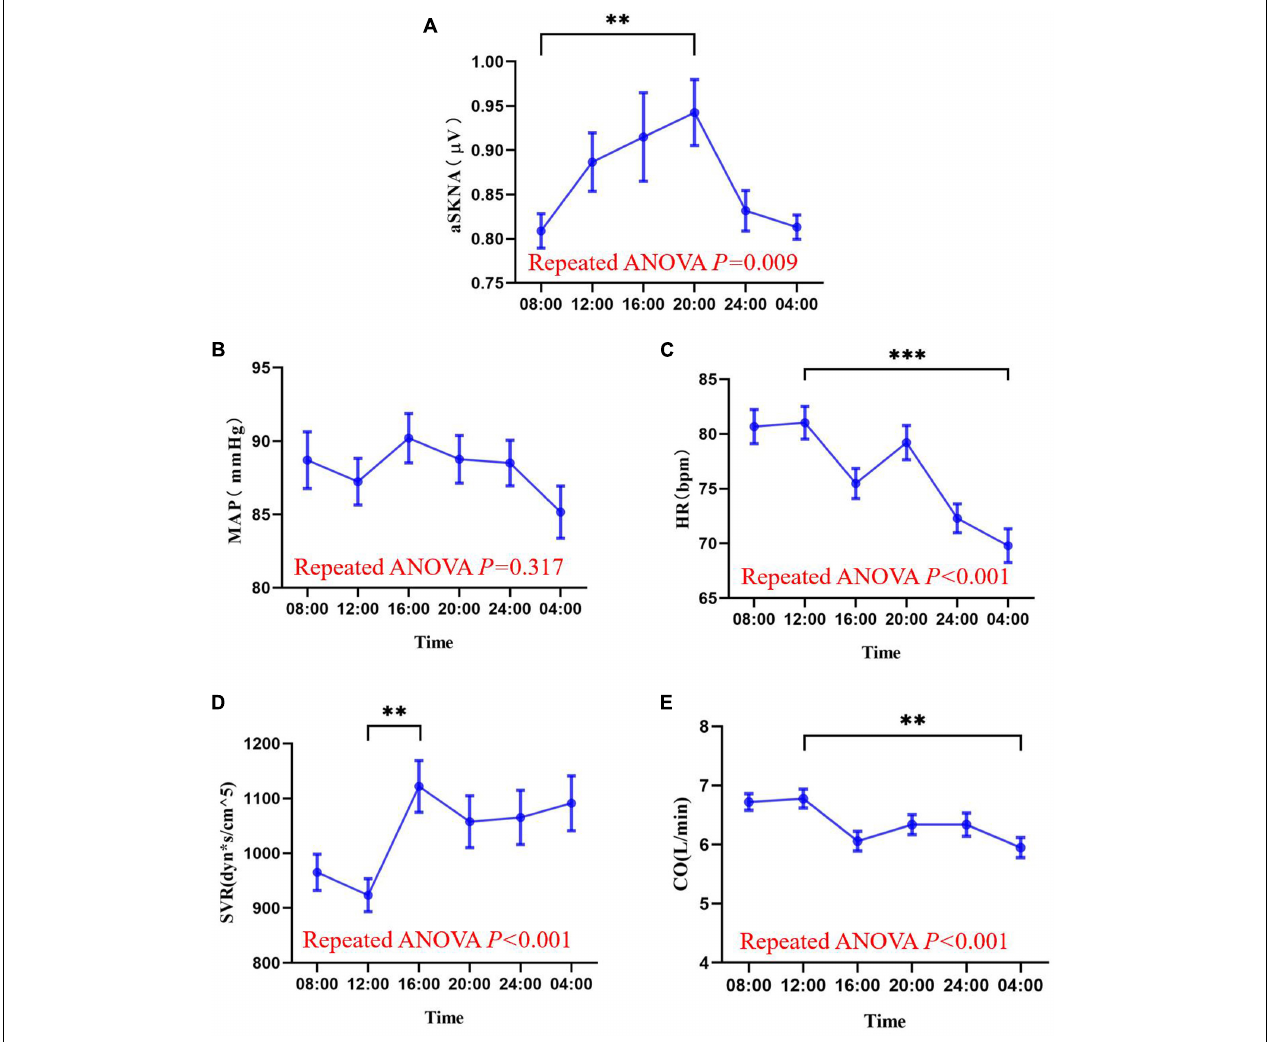
FIGURE 4 | The mean values of average skin sympathetic nerve activity (A) , mean arterial pressure (B) , heart rate (C) , peripheral vascular resistance (D) , and cardiac output (E) at six time points of the day (08:00, 12:00, 16:00, 20:00, 00:00, 04:00). The data are shown as the mean and standard error. ∗∗ P < 0.01 ; ∗∗∗ P < 0.001. Askna, average skin sympathetic nerve activity; MAP, mean arterial pressure; HR, heart rate; SVR, systemic vascular resistance; CO, cardiac output.